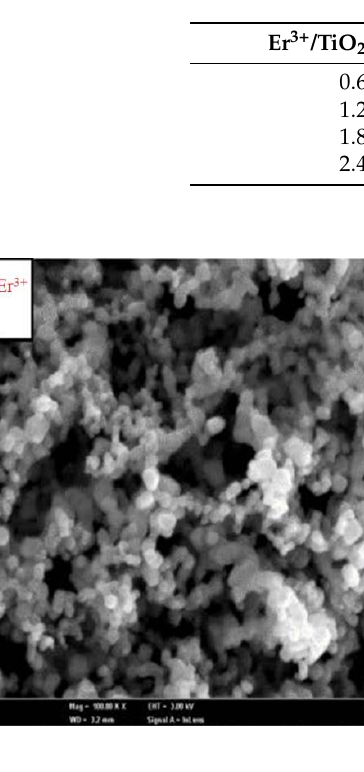
Table 3. EDX analysis of the theoretical and empirical values of the synthesized samples.